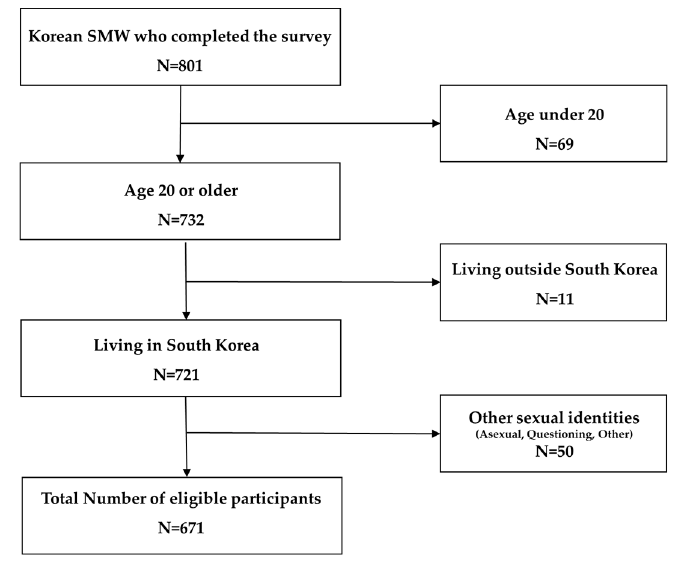
Figure 1. Flow diagram describing the selection of eligible participants.